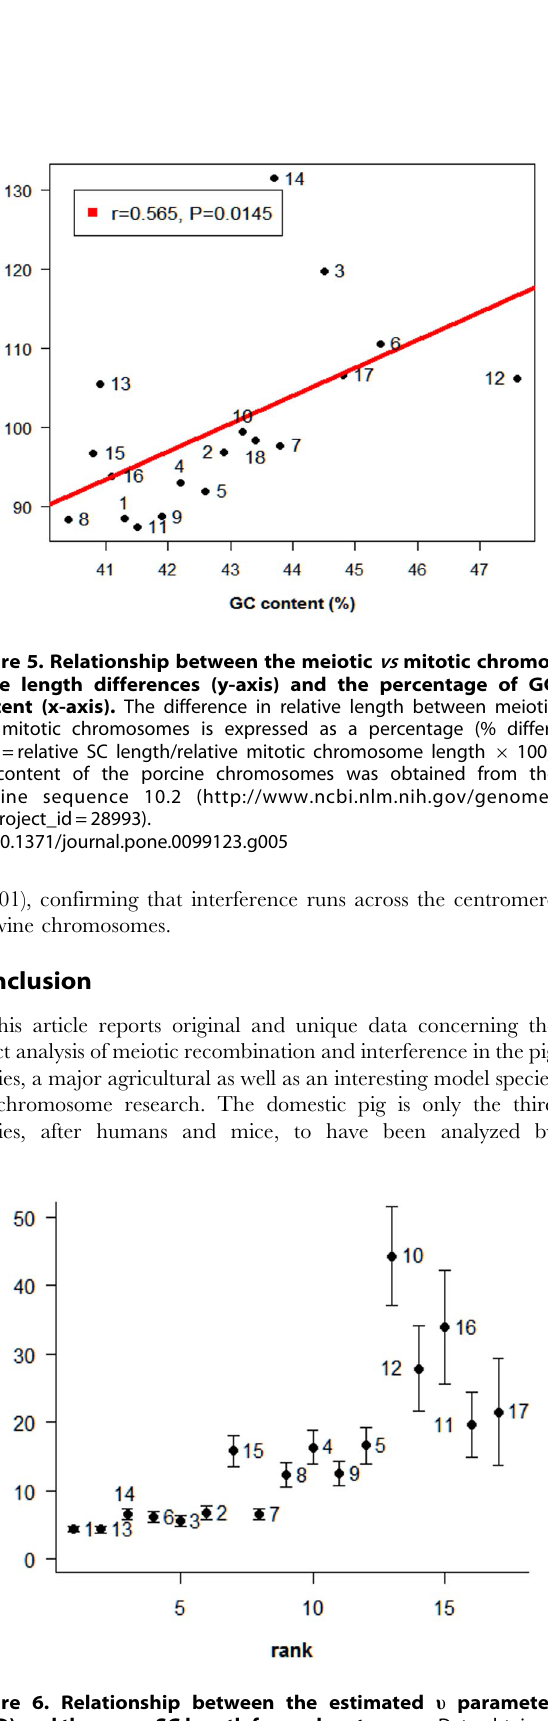
Figure 6. Relationship between the estimated u parameter ( ± SD) and the mean SC length for each autosome. Data obtained from the pooled data of the 2 individuals studied using FISH. There is no value for SSC18 because this chromosome rarely presented more than one MLH1 signal.